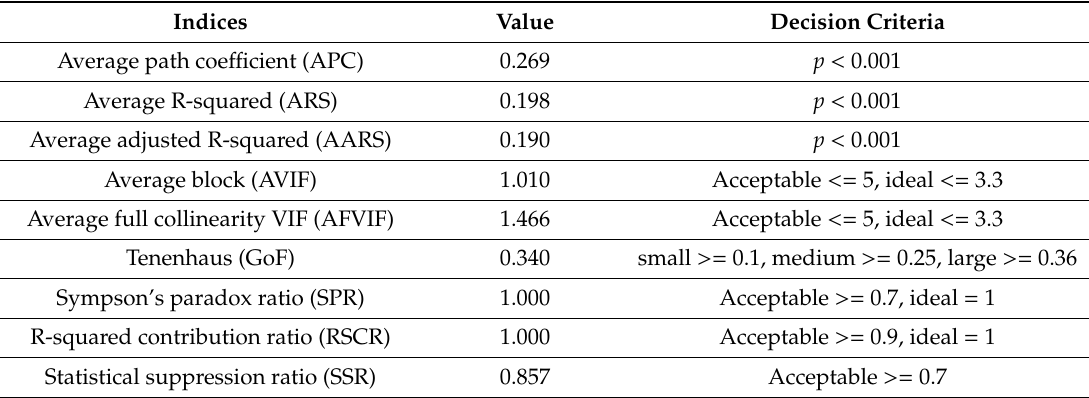
Table 2. Model 1. E ffi ciency indices of the relationships between JCQ dimensions and